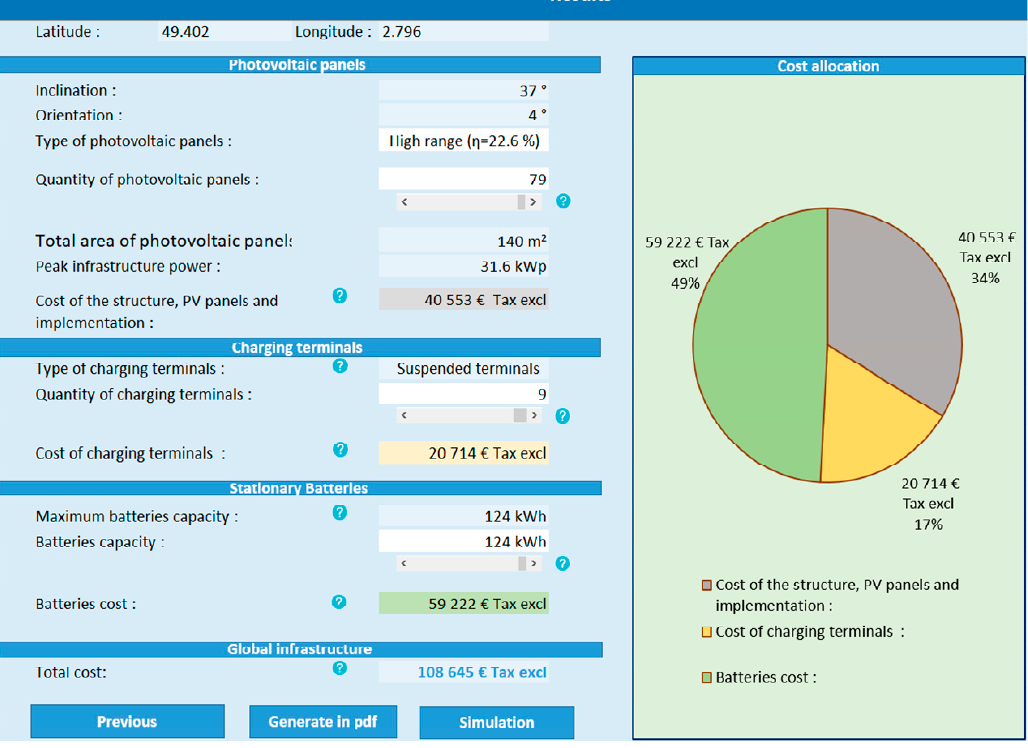
Figure 3. Interface for the maximum sizing in the first phase.